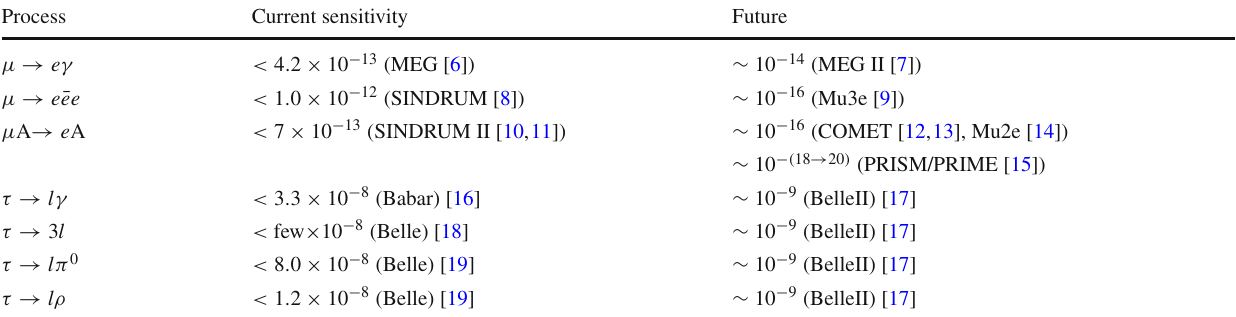
Table 1 Current bounds on the branching ratios for various lepton flavour changing processes, and the expected reach of upcoming experiments Process Current sensitivity